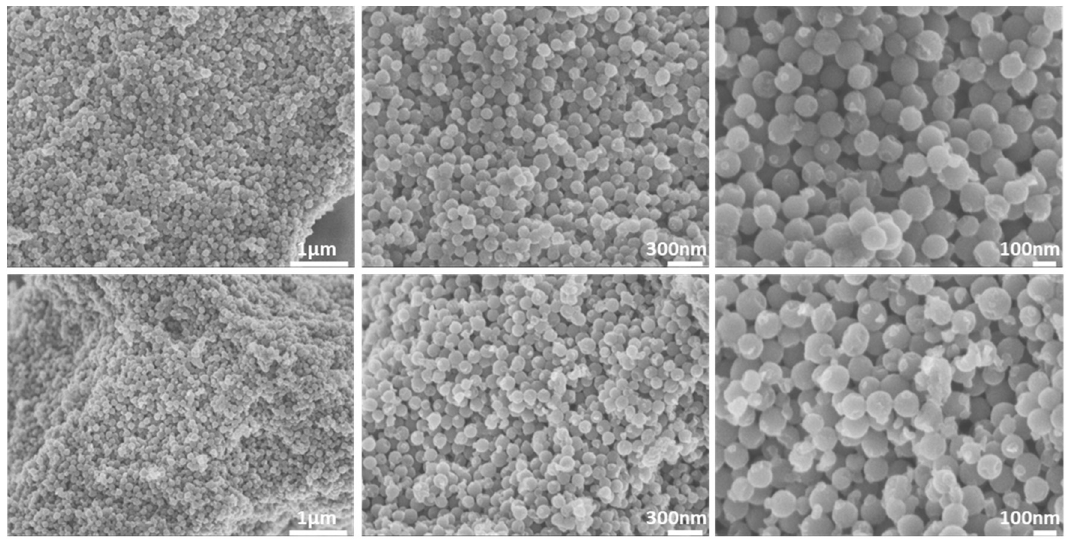
Figure 1. SEM images of the CMK-1 carbon spheres before ( top ) and after incubation with SGF ( bottom ).